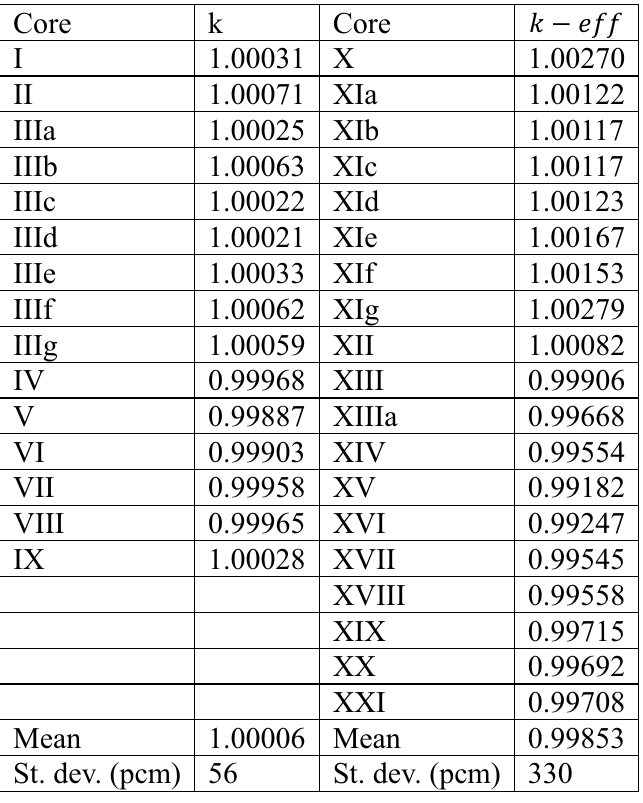
Figure 4. CASMO5 multi-assembly depiction of B&W 1484 Core X (left) and XI (right). Isolation sheets are depicted as vertical and horizontal slabs. Table III. CASMO5 B&W 1484 critical experiments : k–eff results